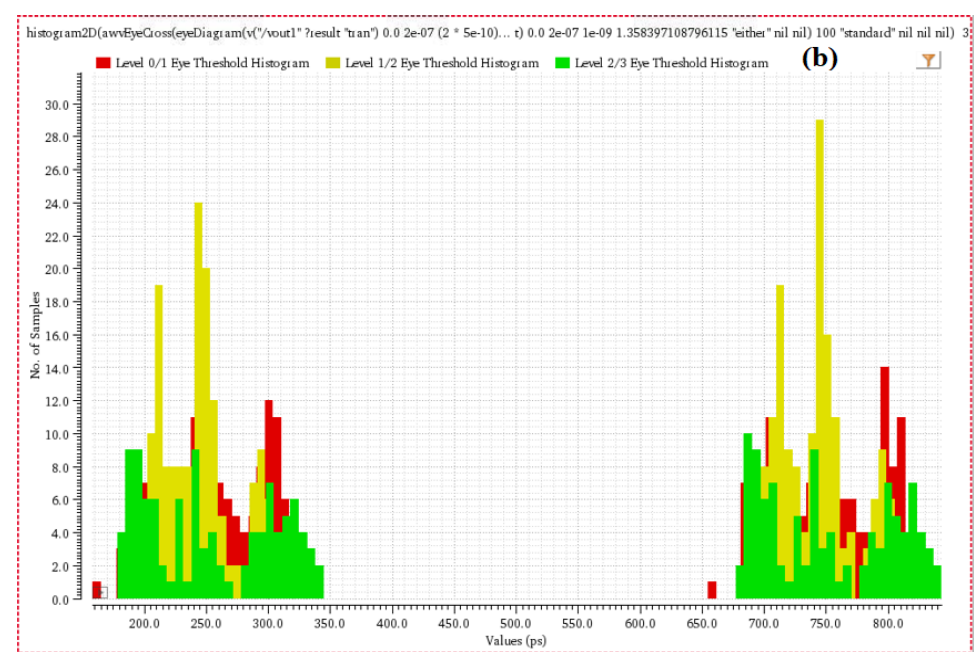
Figure 19. ( a ) Histogram of the eye diagram reveals eye widths for levels 0, 1, 2, and 3. ( b ) Threshold histogram of the eye diagram reveals the bit period of levels 0/1, 1/2, and